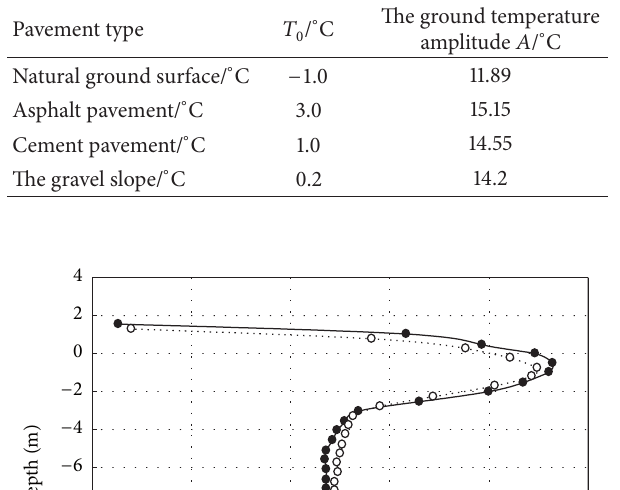
Figure 5: Measured and calculated temperature values at the maximum thawed depth of embankment center a year after the